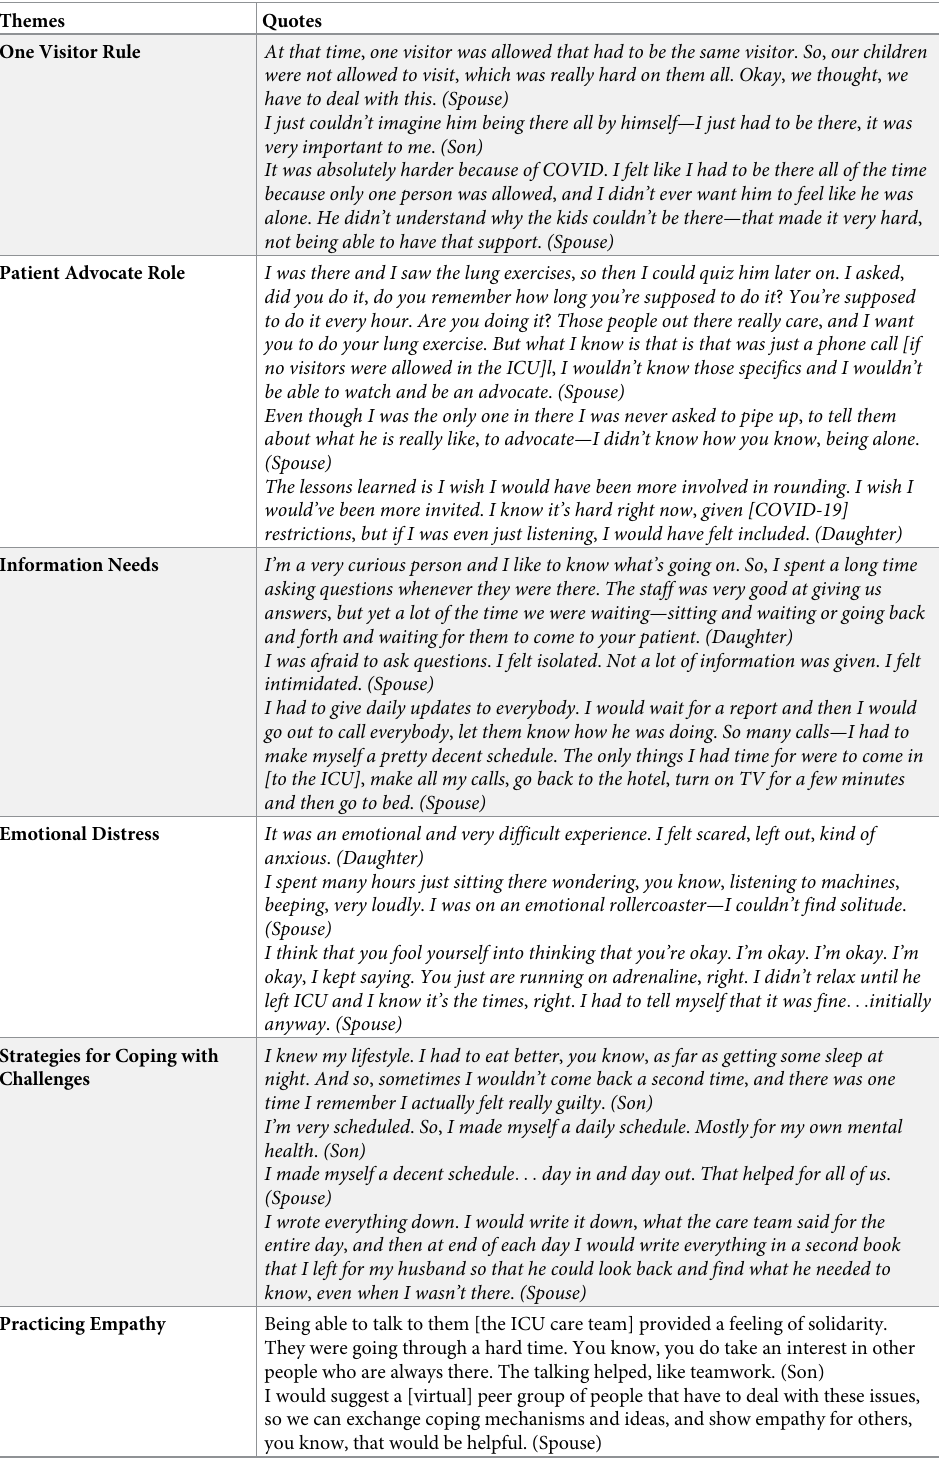
Table 2. Perspectives of designated family caregivers on caring for critically ill loved ones admitted to an intensive care unit during the COVID-19